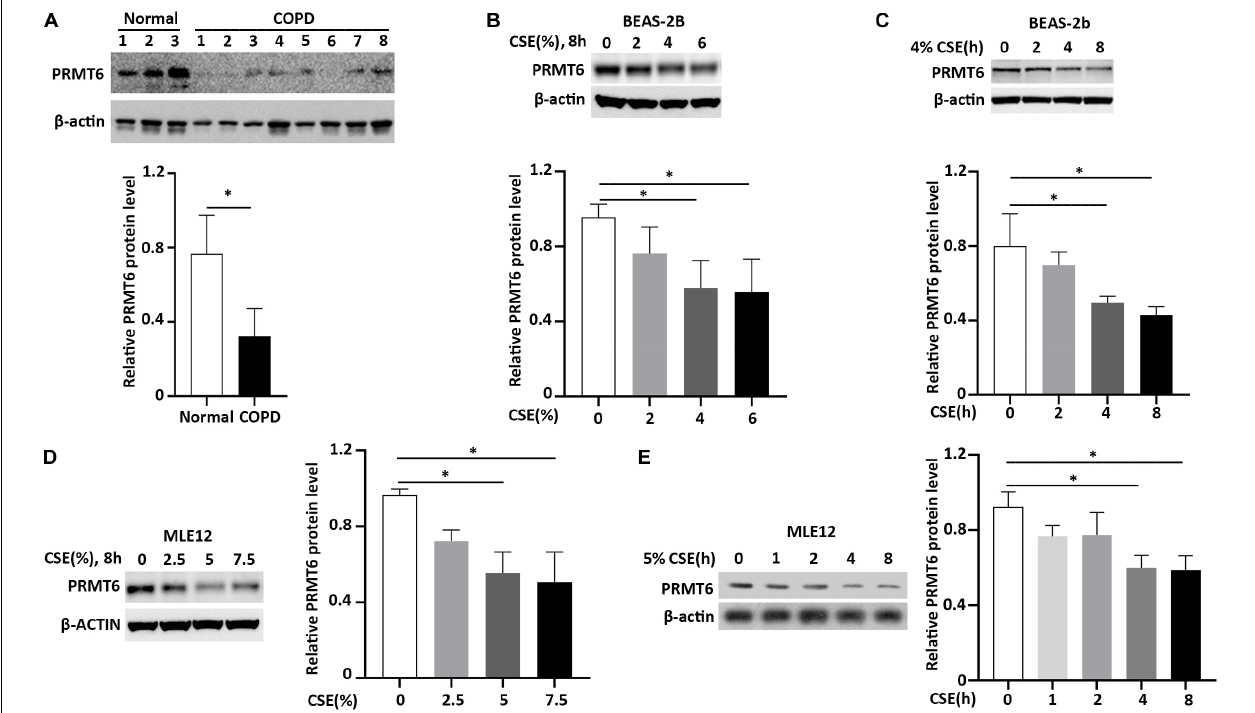
FIGURE 1 | Cigarette smoke extract (CSE) diminishes protein arginine N-methyltransferase 6 (PRMT6) protein expression. (A) Lung tissue of chronic obstructive pulmonary disease (COPD) patients and healthy controls were lysed for PRMT6 and β -actin immunoblotting. The densitometry results of PRMT6 protein expression are plotted in the right-hand panel. (B) CSE (2, 4, and 6%) was applied to treat BEAS-2B cells for 8 h. Cell lysate were collected and applied to immunoblotting. The plotted densitometric results were presented in the lower panels. (C) BEAS-2B cells were stimulated with 4% CSE for 2, 4, and 8 h. Immunoblotting was performed to examine PRMT6 protein expression. Lower panels showed the densitometric results of the blots. (D) Murine lung epithelial cells (MLEs) were treated with 2.5, 5, and 7.5% CSE. (E) CSE (5%) was applied to MLE12 cells for a range of time points. Cell lysate was analyzed with PRMT6 or β -actin immunoblotting. The relative expression of PRMT6 protein is plotted in the right-hand panel. Data represent n = 3 separate experiments. The graph shows mean ± SD and “ ∗ ” denotes p < 0.05. The black line and “ ∗ ” indicated the differences between groups.